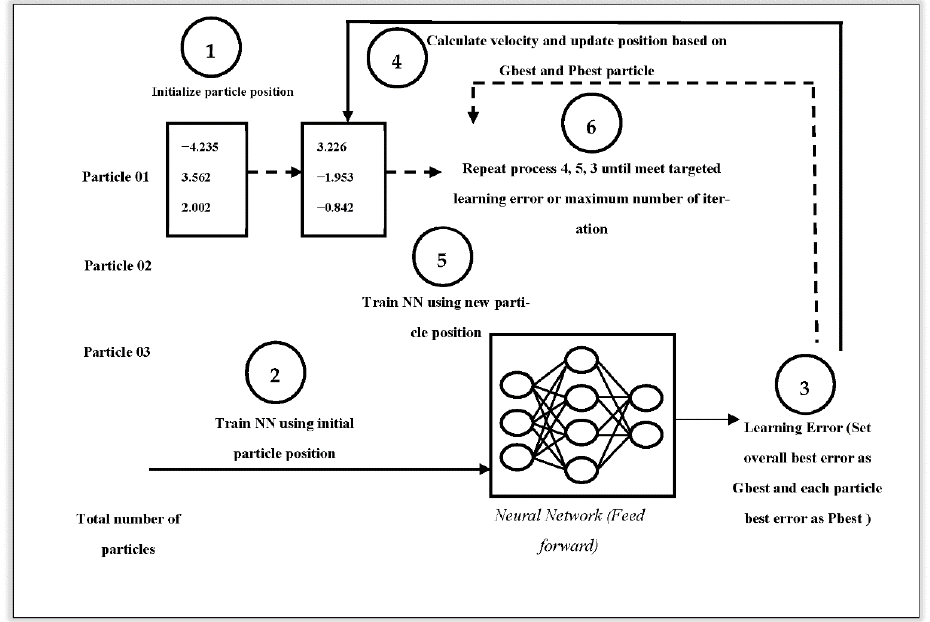
Figure 8. Feed-forward neural network.